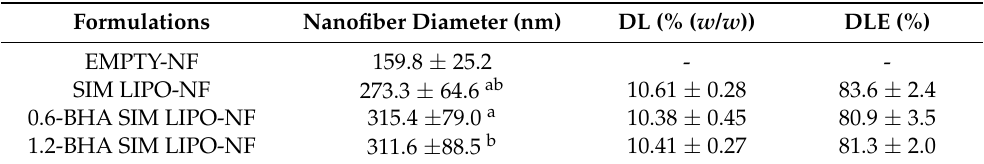
Table 2. Characterization of the nano fi brous samples in terms of the average nano fi ber diameter (nm), drug loading (DL, % w / w ), and drug loading e ffi ciency (DLE, %). Small le tt ers indicate couples of statistically di ff erent values.